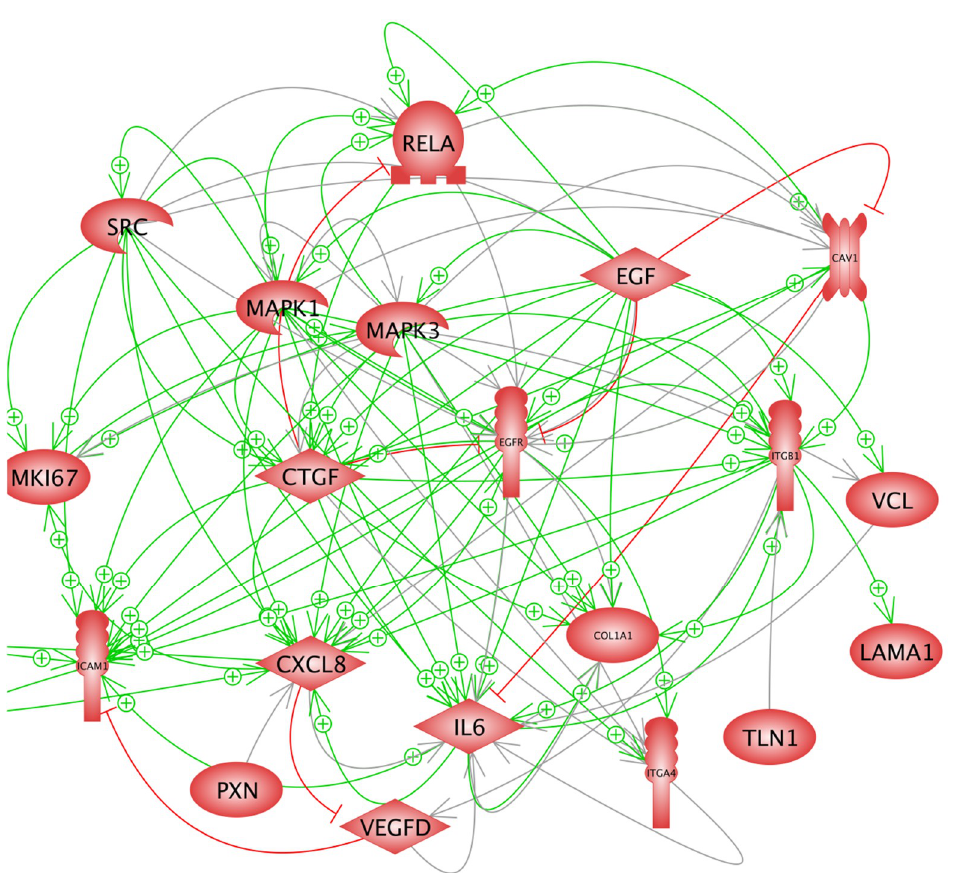
Figure 7. Interaction of the genes analysed by quantitative real-time polymerase chain reaction. Green arrows indicate stimulation and red lines with a terminal crossbar show inhibition. Grey arrows indicate an interaction with an unknown effect. Of note, most of the green arrows start near the SRC and EGF icons.